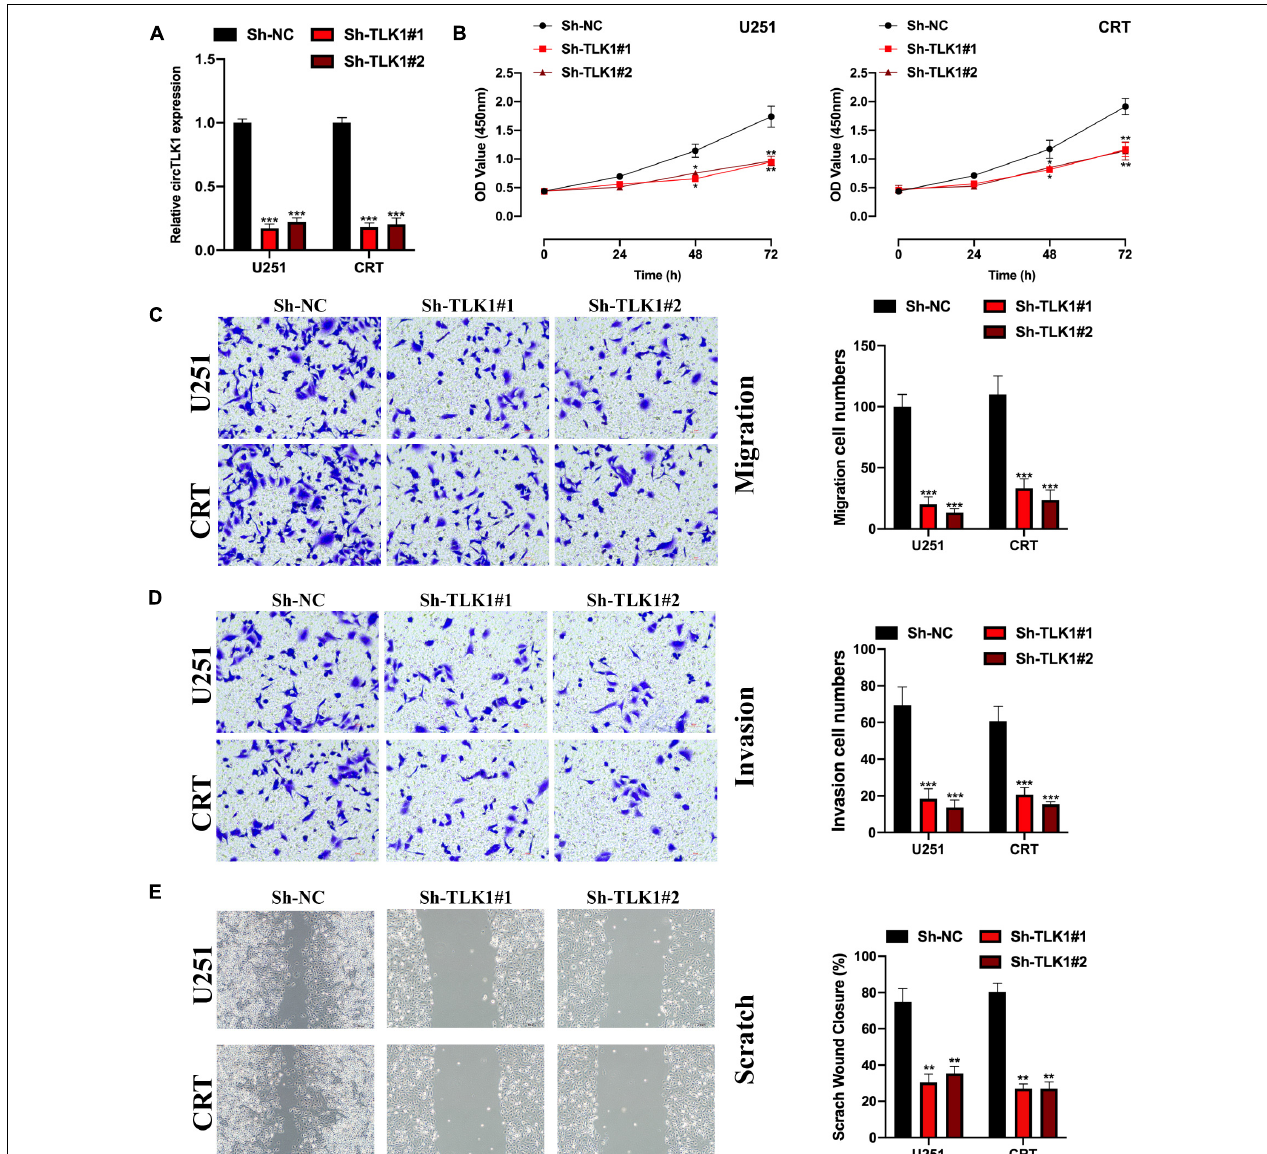
FIGURE 2 | Downregulated circTLK1 inhibits glioma cell proliferation, migration, and invasion. (A) Transfection efficiencies of Sh-NC, Sh-circTLK1#1, Sh-circTLK1#2 in U251, and CRT detected using qRT-PCR. (B) CCK-8 assay assessing the cell proliferation abilities. (C) Transwell migration assay was performed to measure the cell migration levels. (D) Transwell invasion experiment was applied to detect cell invasion abilities. (E) Scratch test was applied to evaluate the migration ability of transfected cells. Comparative statistics are shown here. **p < 0.01, ***p <